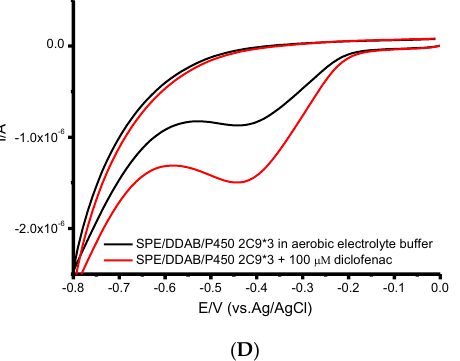
Figure 2. ( A ) Cyclic voltammogram of P450 2C9 immobilized on SPE/DDAB (SPE/DDAB/P450 2C9) in argon-saturated (-) and aerobic (-) electrolyte buffer, scan rate 100 mV/s. ( B ) Cyclic voltammograms of SPE/DDAB/P450 2C9 in aerobic (-) electrolyte buffer and in the presence of 100 µ M diclofenac (-). ( C ) Cyclic voltammograms of SPE/DDAB/P450 2C9*2 in aerobic saturated (-) electrolyte buffer and in the presence of 100 µ M diclofenac (-). ( D ) Cyclic voltammograms of SPE/DDAB/P450 2C9*3 in aerobic (-) electrolyte buffer and in the presence of 100 µ M diclofenac (-). Table 2. Electrocatalytic parameters of cytochromes P450 2C9, 2C9*2, and 2C9*3 immobilized on SPE/DDAB under aerobic conditions (0.1 M potassium phosphate buffer, pH 7.4, containing 0.05 M NaCl). The parameters were calculated at a scan rate of 100 mV/s, the concentration of diclofenac is 100 µM. Ered is the potential of cytochrome P450 reduction, Еcat is the potential of cytochrome P450 reduction in the presence of substrate (diclofenac), Eonset is the potential of the start of diclofenac electrocatalysis.